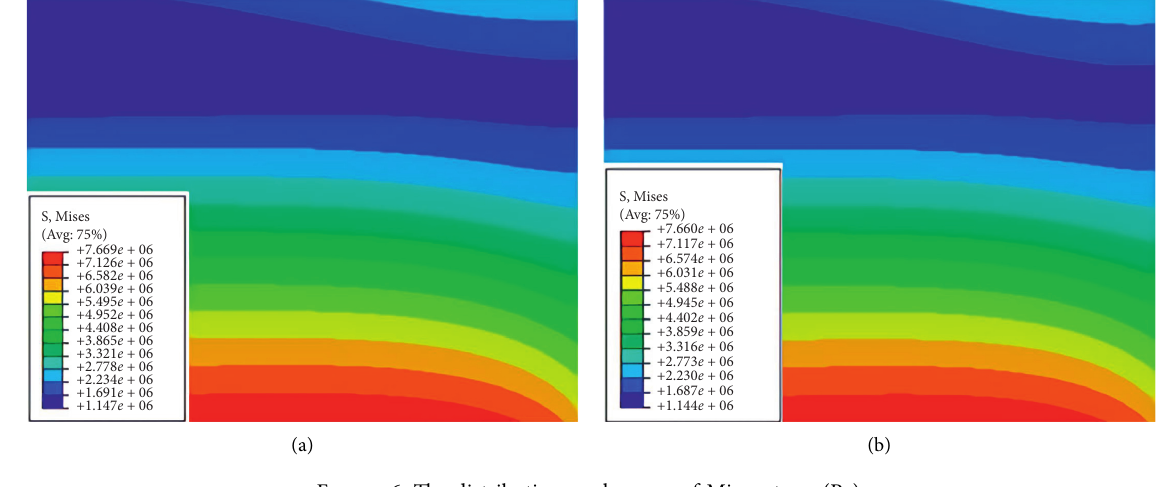
Figure 6: The distribution nephogram of Mises stress (Pa). Table 2: The sample stress got by reduced order model and full order model.